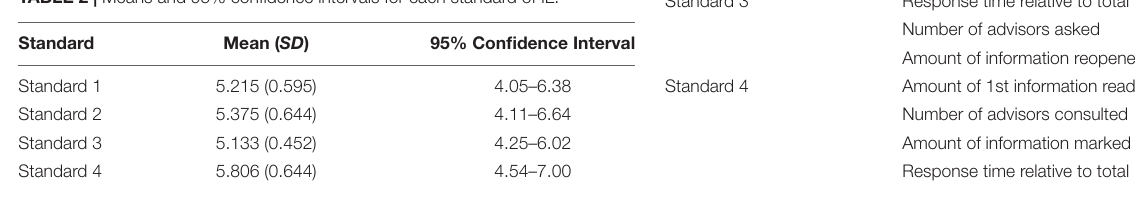
TABLE 2 | Means and 95% confidence intervals for each standard of IL.